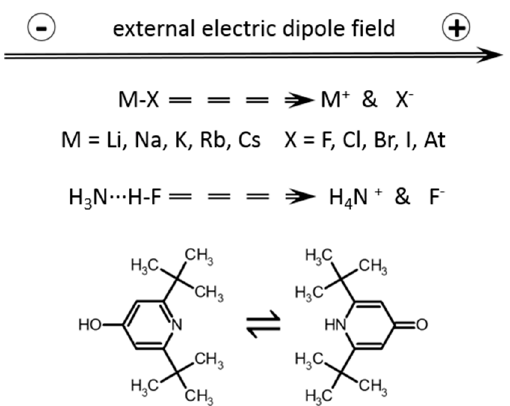
Figure 1. Molecular systems studied in this work and the direction of the external electric field acting on them.